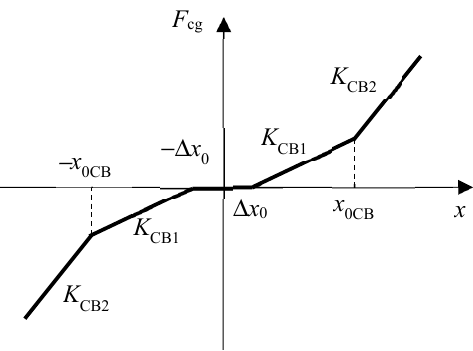
Figure 7. Coupler draft gear device force element.